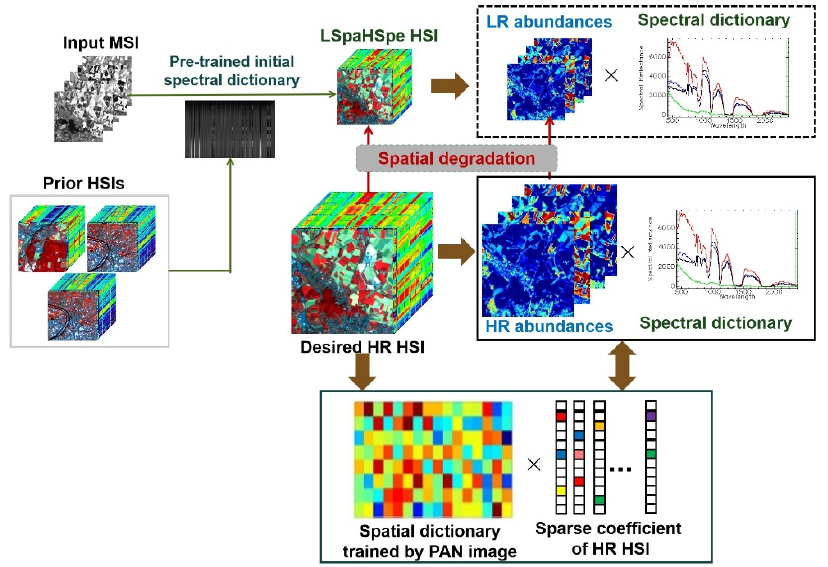
Figure 3. A spectral observation model.